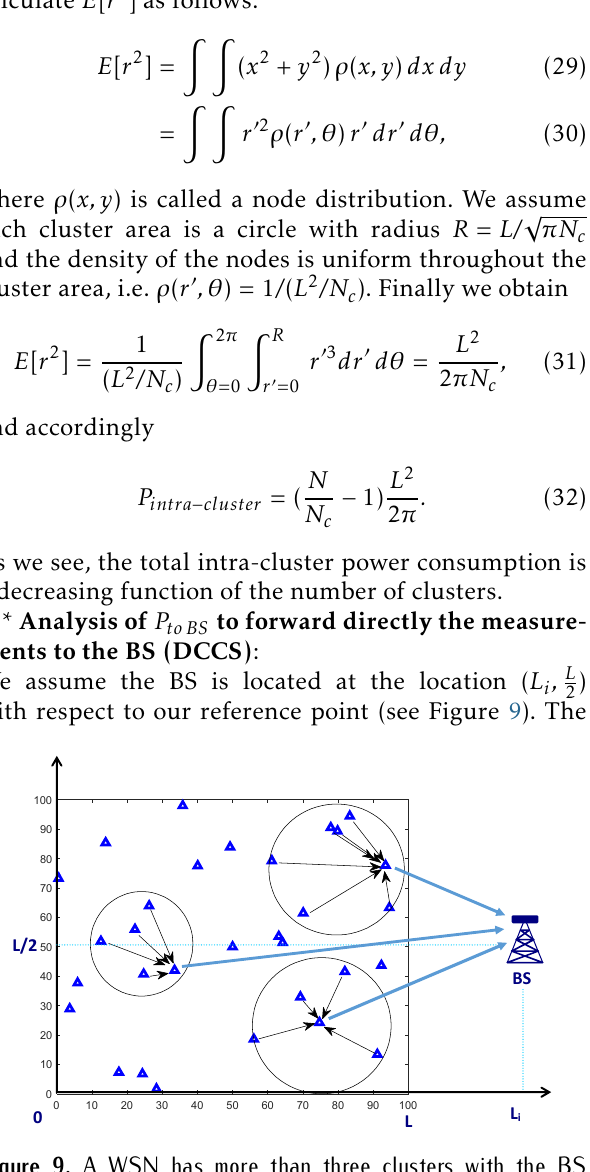
Figure 9. A WSN has more than three clusters with the BS outside the sensing area ( L i > L